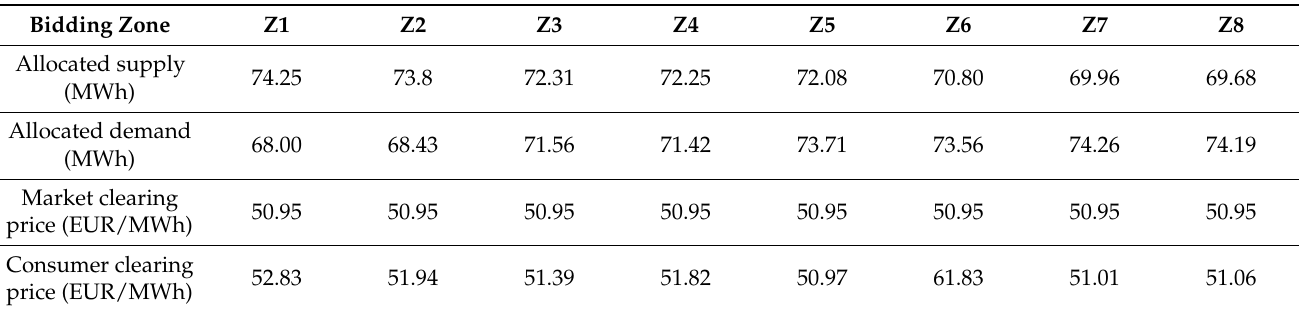
Table 3. Main clearing results of the first simulated